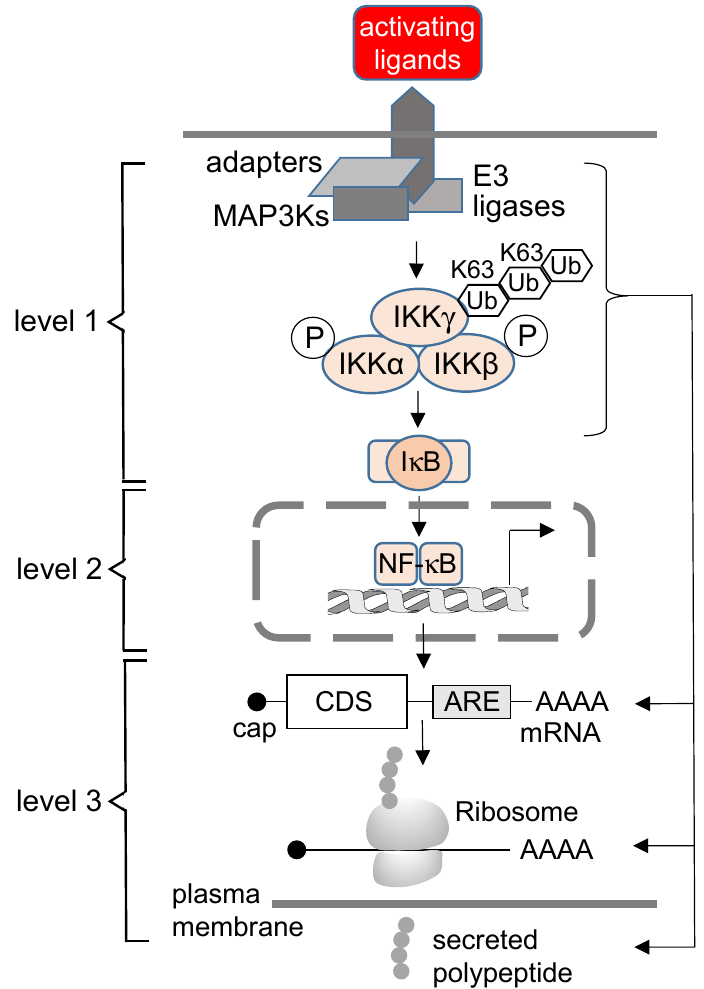
Figure 1. The concept of three levels of regulation in the NF- κ B system. For details, see text (CDS, coding sequence; MAP3K, mitogen-activated protein kinase kinase kinase).